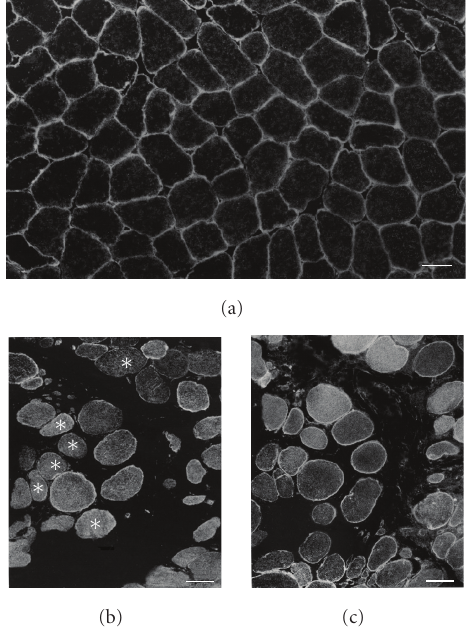
Figure 2: Immunofluorescence with anti-AQP4 antibody of normal control muscle (a) and Duchenne muscular dystrophy muscle (DMD) (b), and that with anti-spectrin antibody of serial muscle section of DMD (c). Positive immunoreactivity with anti- AQP4 antibody is seen in apparently all myofibers of normal control muscles (a); while it is noted in mosaic pattern in DMD muscle (b). DMD muscle contains less numerous myofibers with positive immunoreactivity of anti-AQP4 antibody (b) than myofibers with that of anti-spectrin antibody (c). Scattered anti- AQP4 immunonegative fibers (asterisks in (b)) are noted in DMD muscle. Scale bar in (a)–(c) = 50 μ